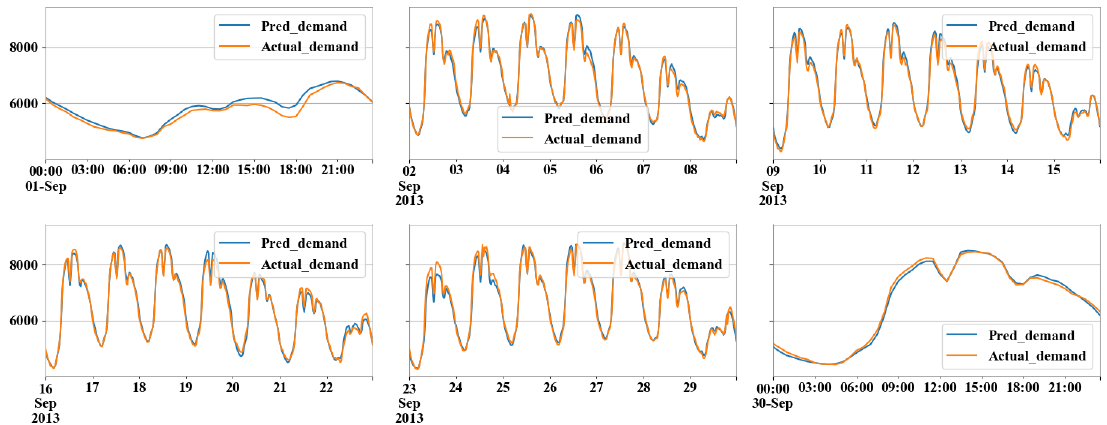
Figure A10. Forecasting performance of OLS for September 2013 (Scenario 4).